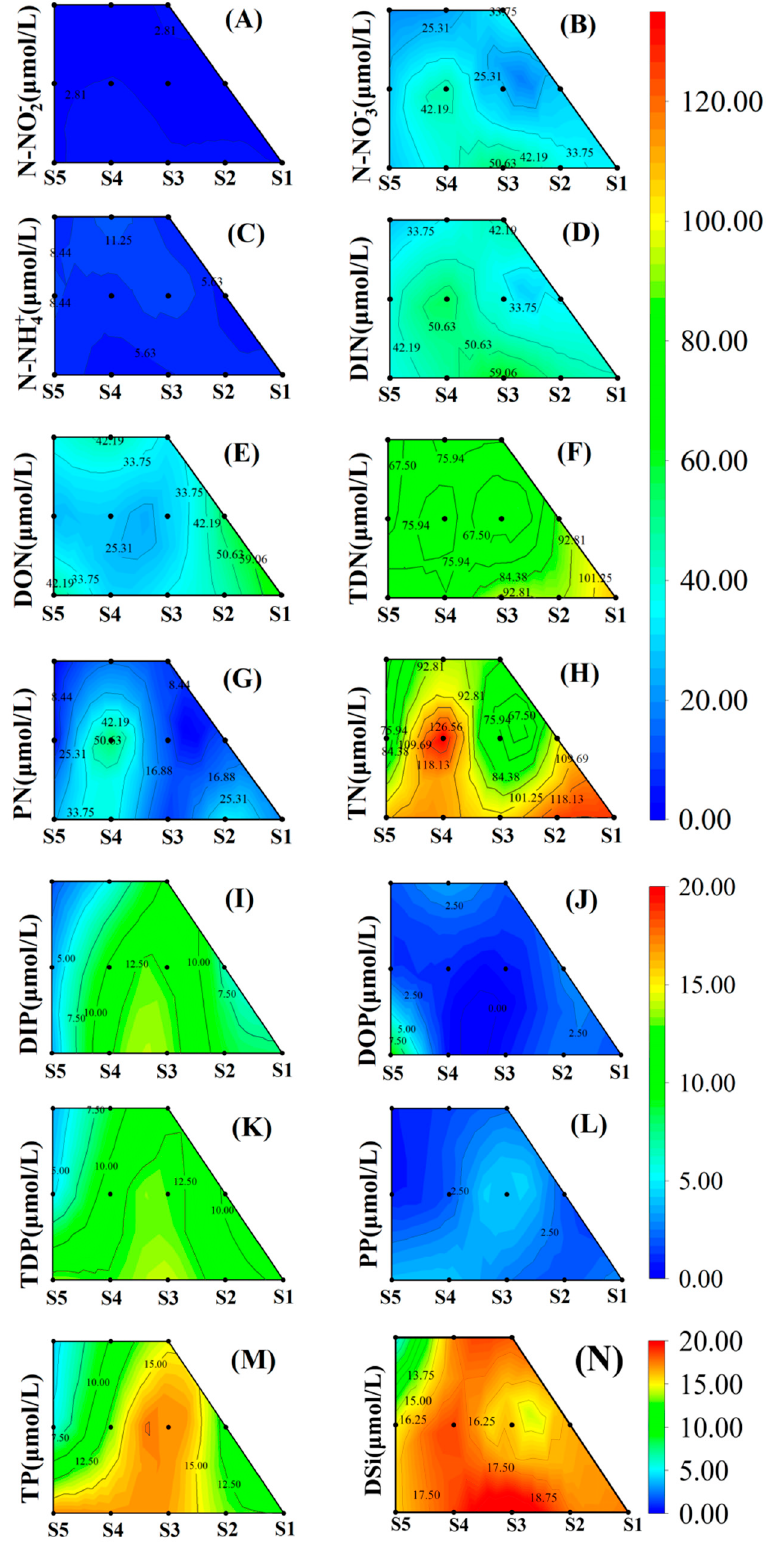
Figure 2. Spatial distribution of N-NO 2 − in JSB ( A ), spatial distribution of N-NO 3 − in JSB ( B ), spatial distribution of N-NH 4 + in JSB ( C ), spatial distribution of DIN in JSB ( D ), spatial distribution of DON in JSB ( E ), spatial distribution of TDN in JSB ( F ), spatial distribution of PN in JSB ( G ), spatial distribution of TN in JSB ( H ), spatial distribution of DIP in JSB ( I ), spatial distribution of DOP in JSB ( J ), spatial distribution of TDP in JSB ( K ), spatial distribution of PP in JSB ( L ), spatial distribu- tion of TP in JSB ( M ), and spatial distribution of DSi in JSB ( N ).